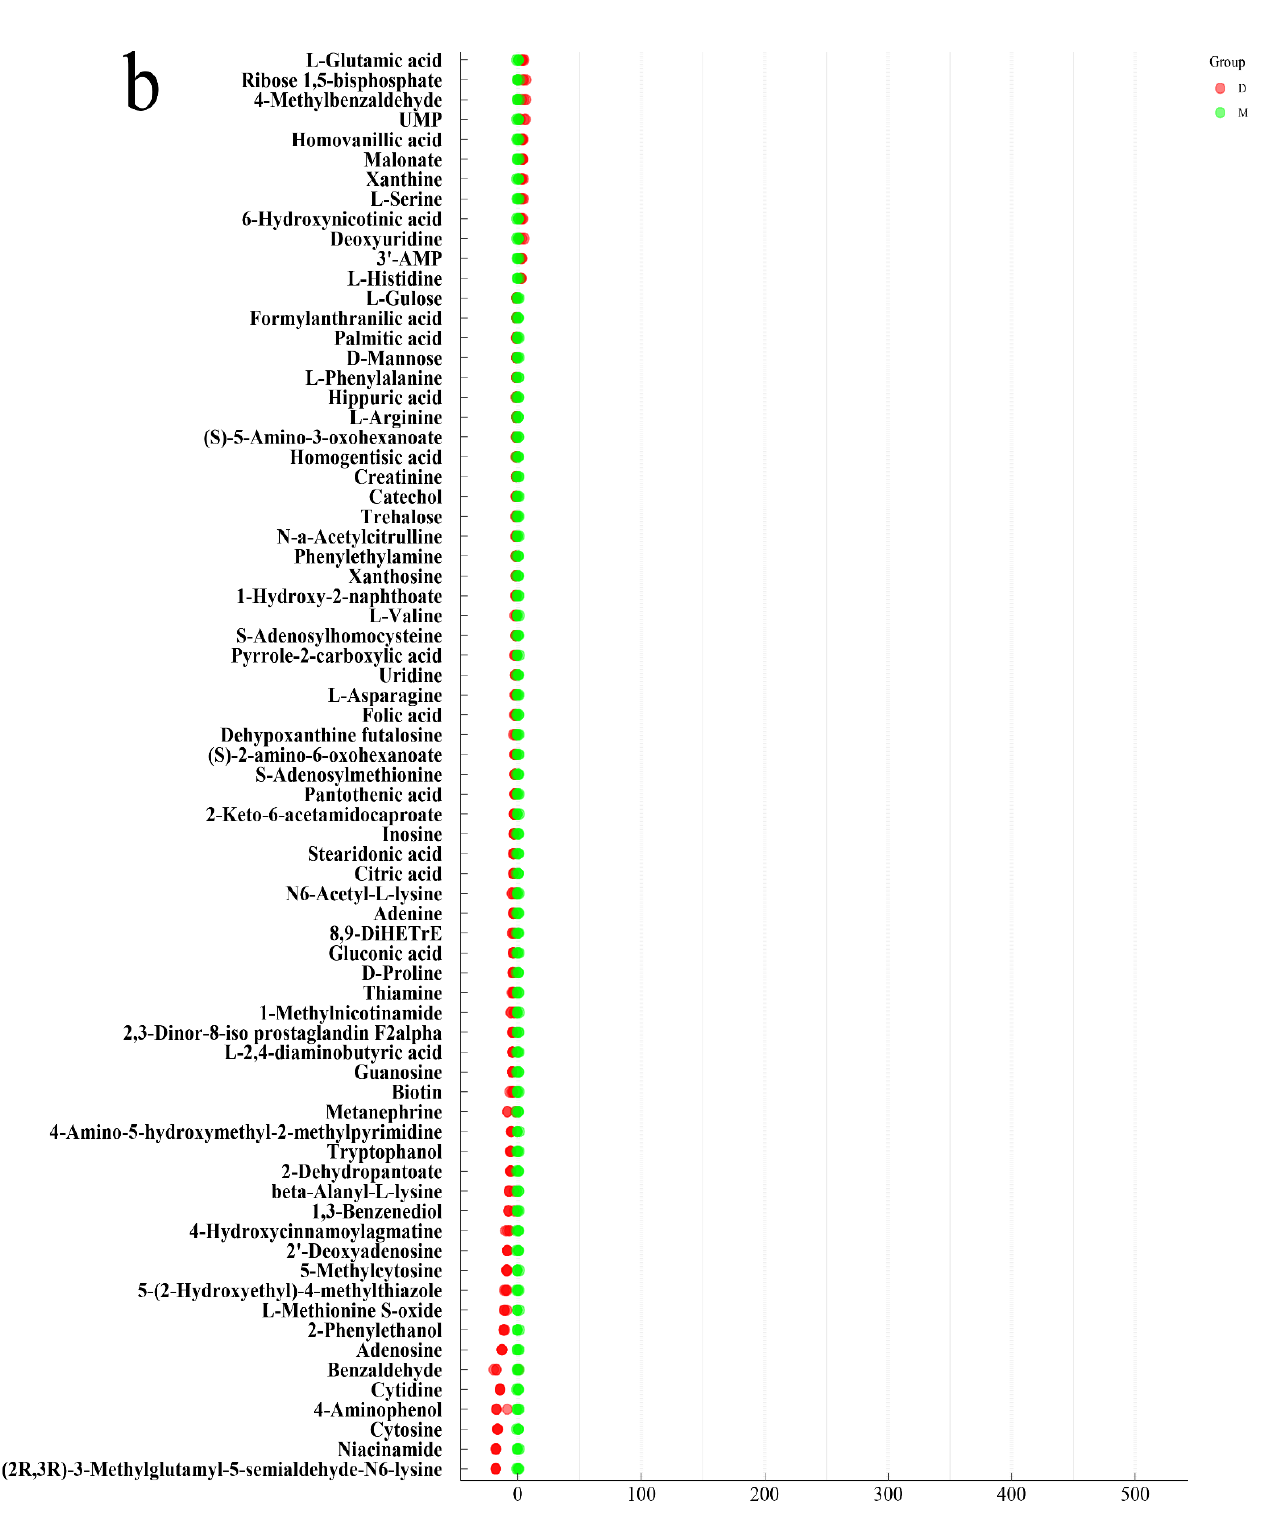
Figure 4. The z-score plot of the L. fermentum RC4 differential metabolites ( a , b ). Note — D: Experimental group; M: MRS broth group. The red and green dots represent the fermentation broth group and culture broth group, respectively, with four replicates in each group, and a greater distance between groups indicates the greater difference in relative content. As shown in Figure 4, the two groups were well aggregated within the group, and the difference between the groups was obvious.